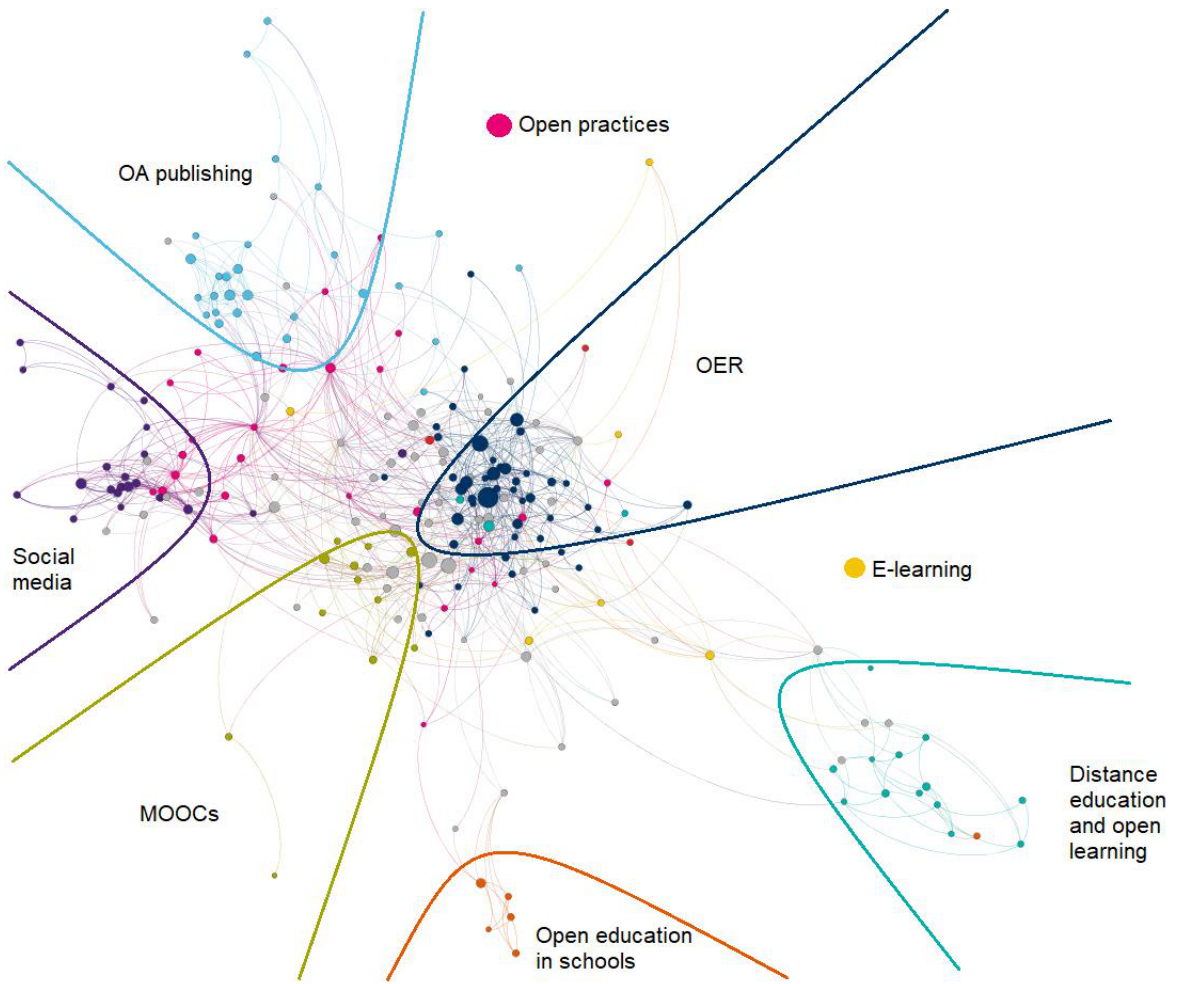
Figure 2: Annotated version of the network. Colour coding indicates categories applied by the researcher, and node size is scaled to reflect the number of times each item is cited within the